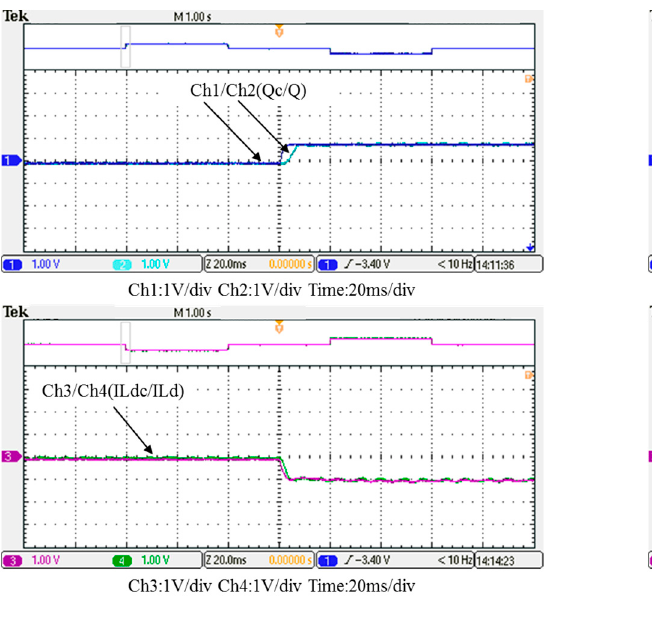
Figure 33. Detailed view of Figure 31: ( a ) near t 1 ; ( b ) near t 2 .